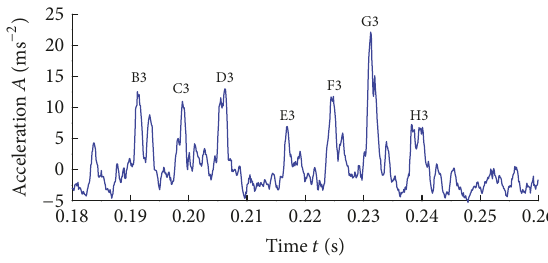
Figure 23: The locally zoomed plot of Figure